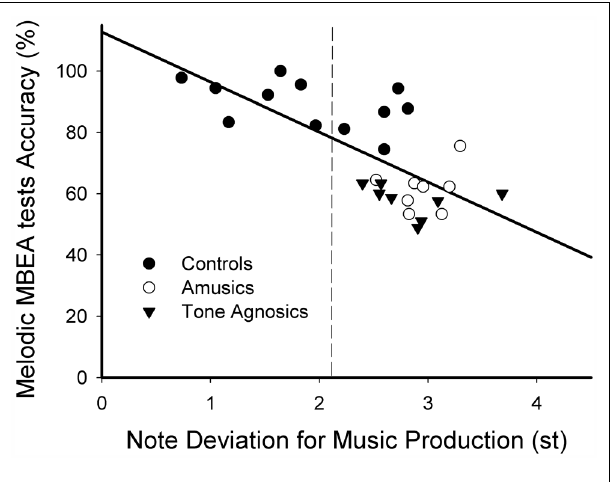
FIGURE 2 |A significant negative correlation between the melodic MBEA score and note deviation for music production tests among the three groups. A dashed line divides two distinct groups based on individual performances on note deviation for the controls, the amusic, and tone agnosic